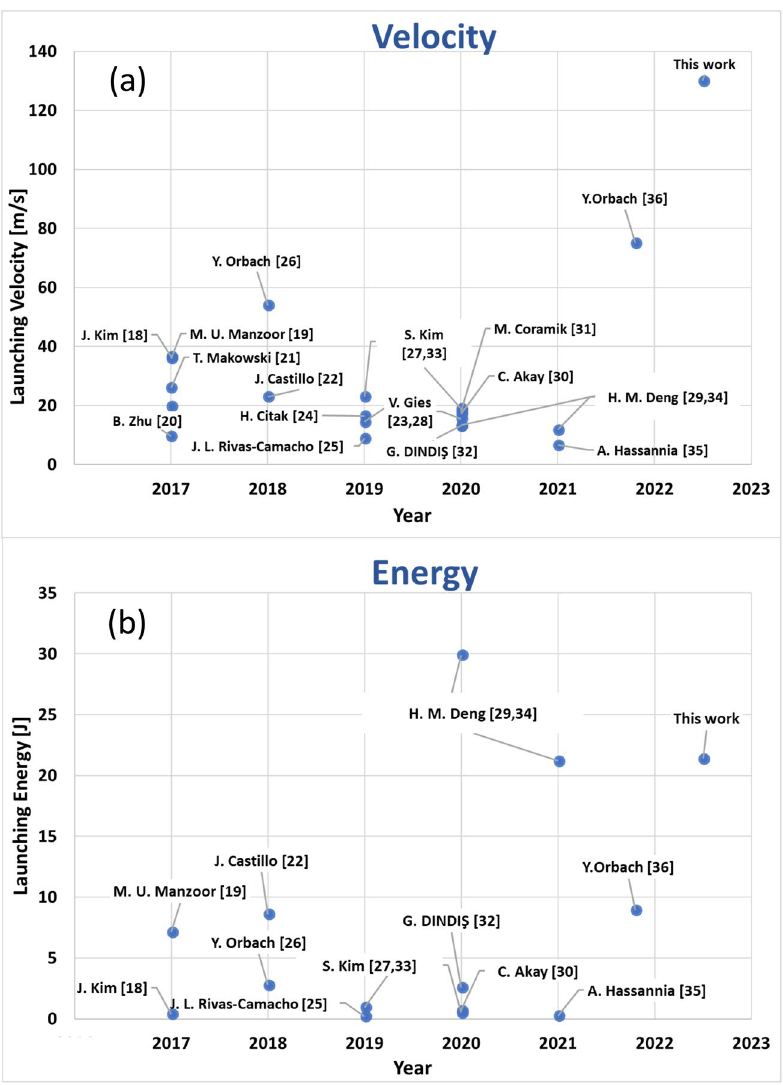
Figure 1. A collection of the launching velocity ( a ) and launching energy ( b ) in the last 5 years of experiments. Every dot represents launching velocities/ energy of an experiment that is in the attached reference